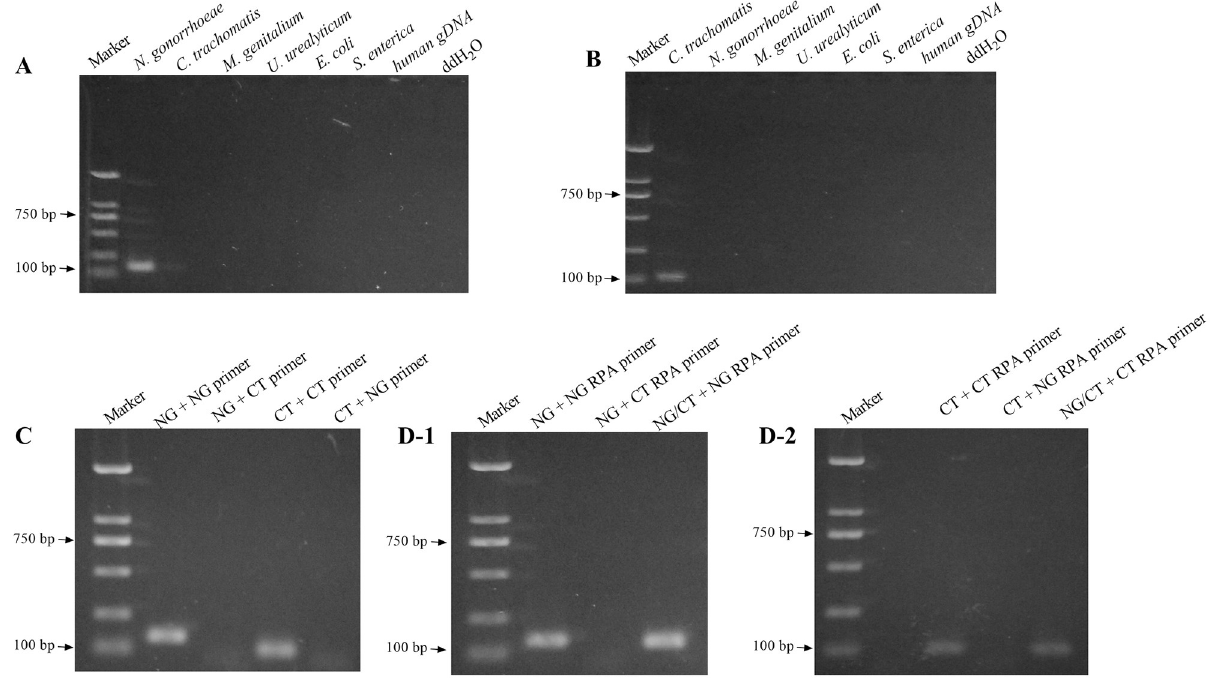
Fig 1. Primer specificity assay and positive control plasmid validation. A and B: RPA was performed using NG-RPA primer pairs and CT-RPA primer pairs with six common pathogenic bacteria including NG and CT and human genomic DNA as templates, and the amplification results were examined by agarose gel electrophoresis. C: NG and CT genomic DNA was subject to PCR using NG-PCR primer pairs or CT-PCR primer pairs, and the amplification results were examined by agarose gel electrophoresis. The primer pairs and templates are grouped as indicated in the figure. D-1 and D-2: NG and CT genomic DNA were used as templates for RPA using NG-RPA primer pairs or CT-RPA primer pairs, and the amplification results were examined by agarose gel electrophoresis. The primer pairs and templates were grouped as indicated in the figure.